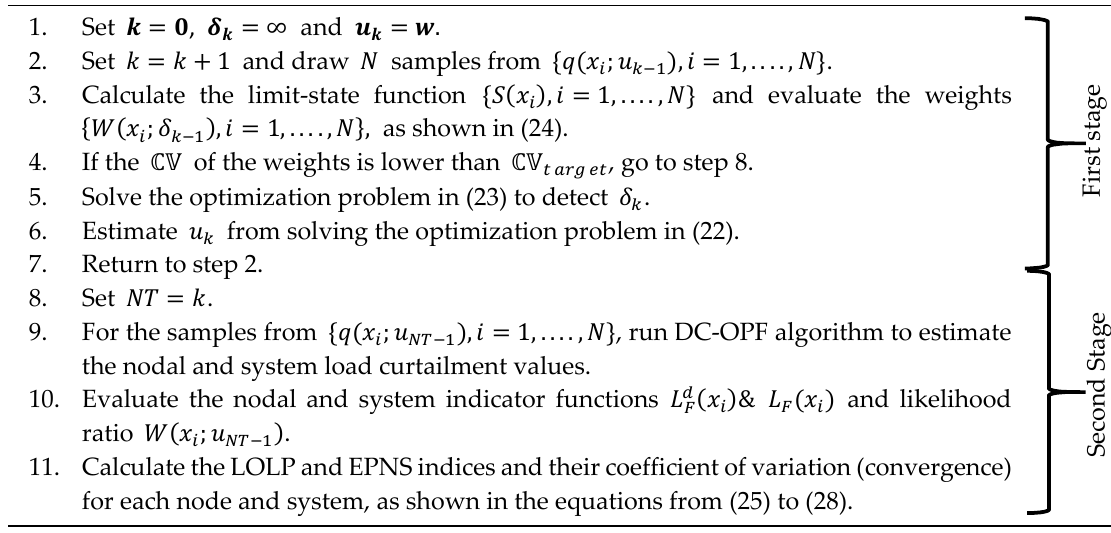
Algorithm 1. Procedure of adequacy indices assessment using ECE-IS